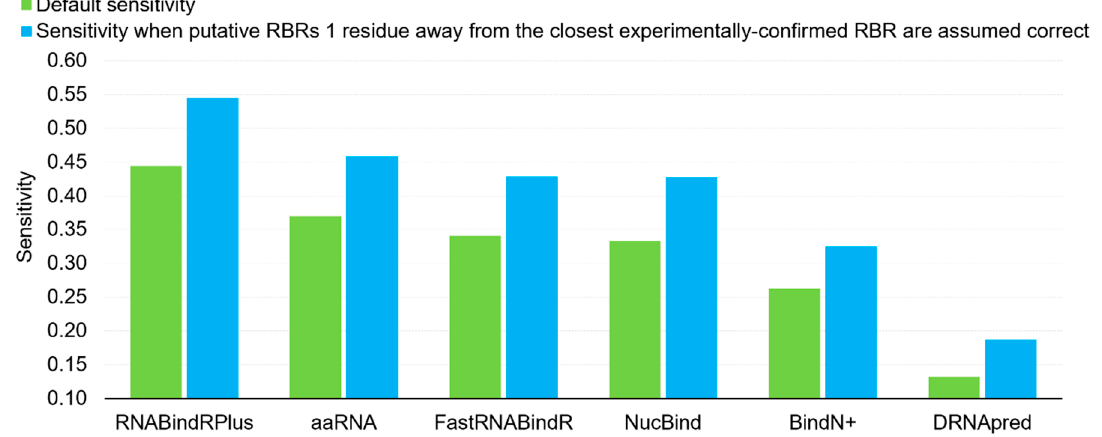
Figure 1. Comparison of the default sensitivity (green bars) and the sensitivity when putative RBRs that are immediate neighbors (one residue away in the sequence) of the experimentally annotated RBRs are assumed correct (blue bars).